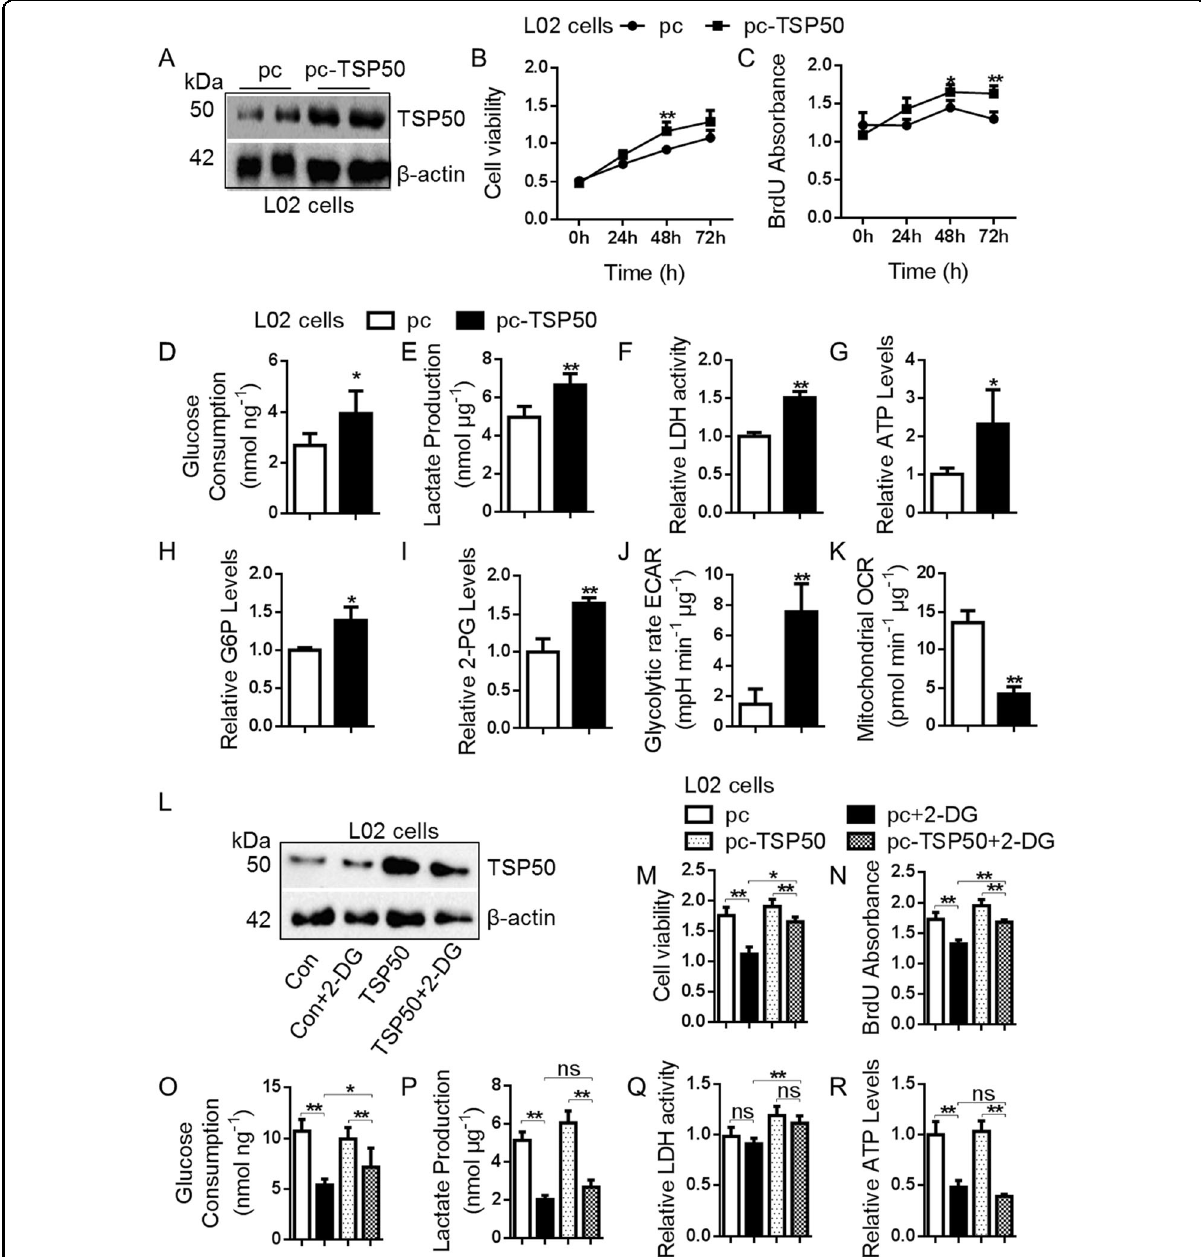
Fig. 3 Over-expressed TSP50 affects cell proliferation and aerobic glycolysis. A pcDNA3.1-TSP50 was transfected into L02 cell to overexpress TSP50 and ef fi cient expression of TSP50 was examined by Western blot. B , C The L02 cell viability and BrdU absorbance were detected in cells after pcDNA3.1-TSP50 transfection by MTT and BrdU assay. D – K After pcDNA3.1-TSP50 transfected in L02 cells, the ECAR, OCR, glucose consumption,